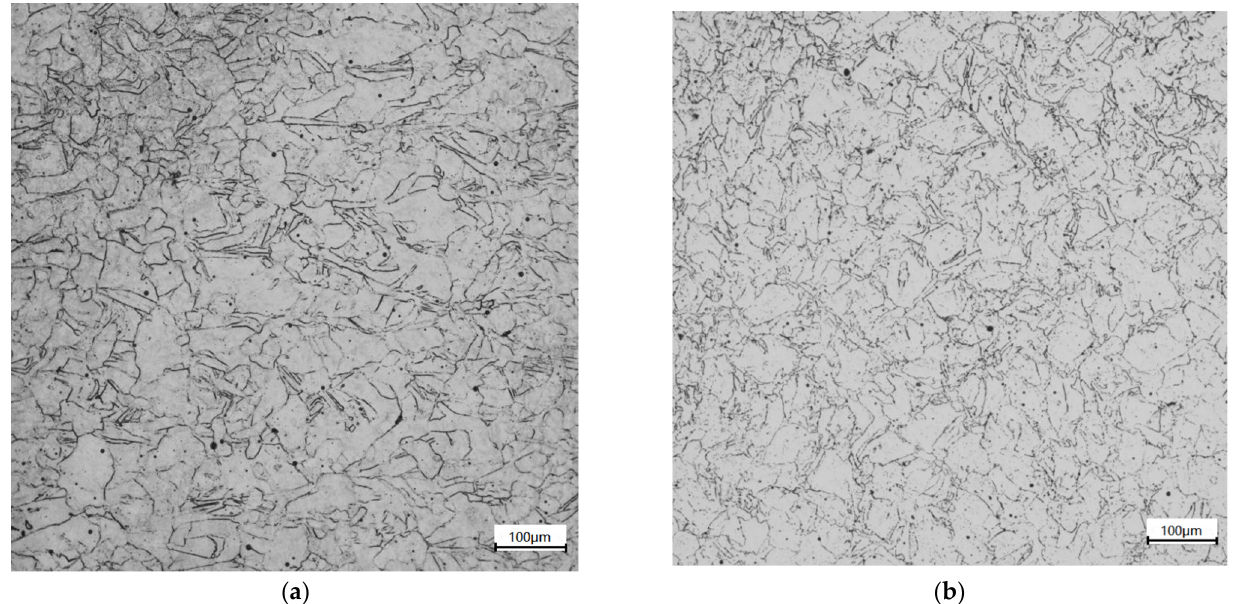
Figure 9. Metallographic structure of original time section. Experimental results ( a ) compression specimen, ( b ) tensile specimen.